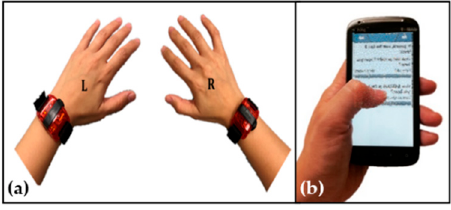
Figure 1. Device configuration of ( a ) accelerometers and ( b ) ecological momentary assessment (EMA) smartphone.